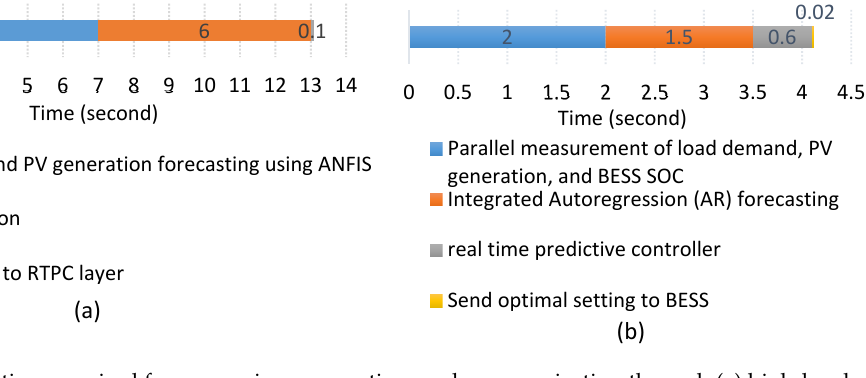
Figure 13. Net time required for measuring, computing, and communicating through ( a ) high-level energy management layer (repeated every 15 min); ( b ) real-time predictive controller layer (repeated every 1 min).